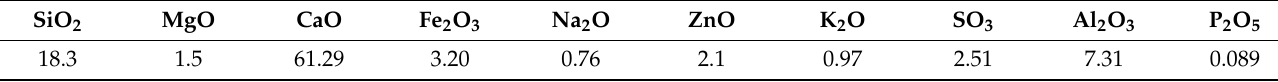
Table 1. Percentage composition of ordinary Portland cement.